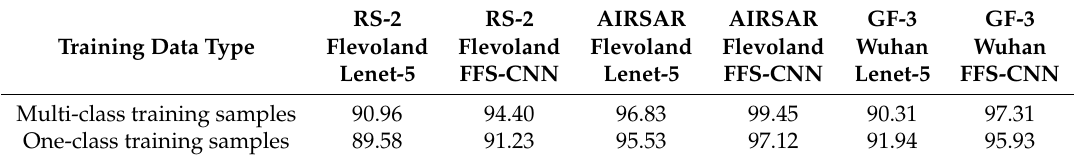
Table 7. The OAs of different training data